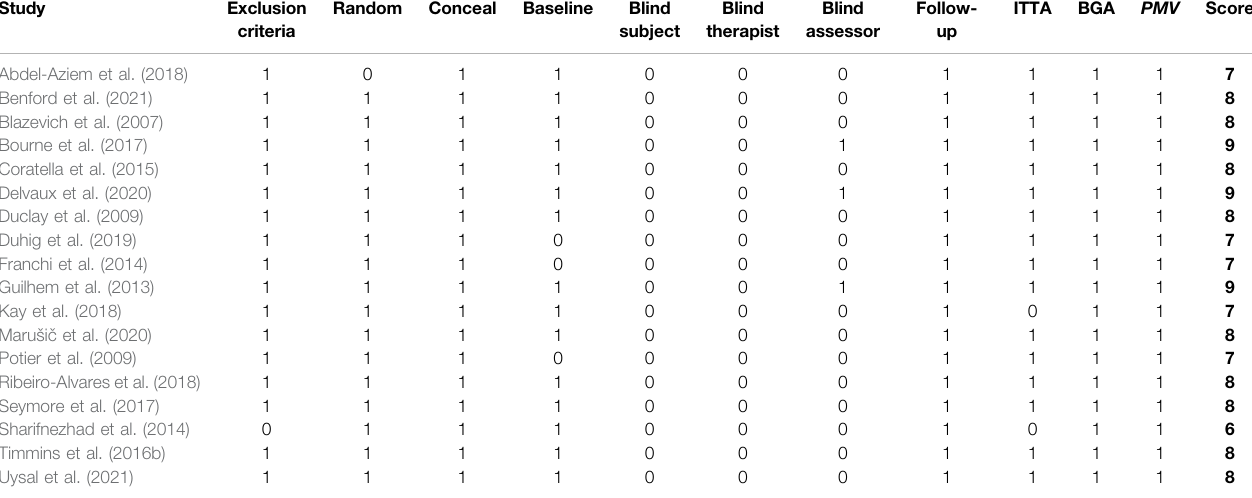
TABLE 4 | Rating of methodological